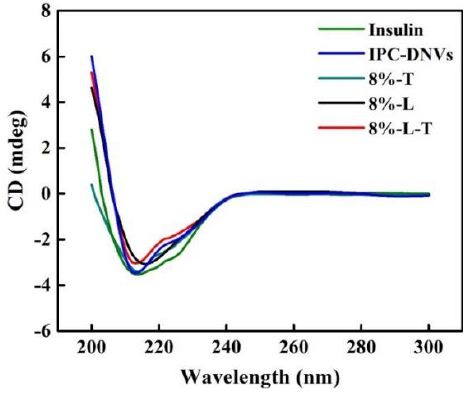
Figure 6. CD spectra of samples before and after lyophilization.